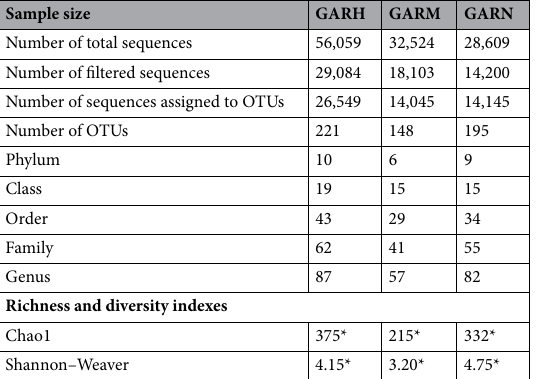
Table 1. Statistical summary of the microbiota from Rhipicephalus microplus . *Significant differences (P < 0.01).